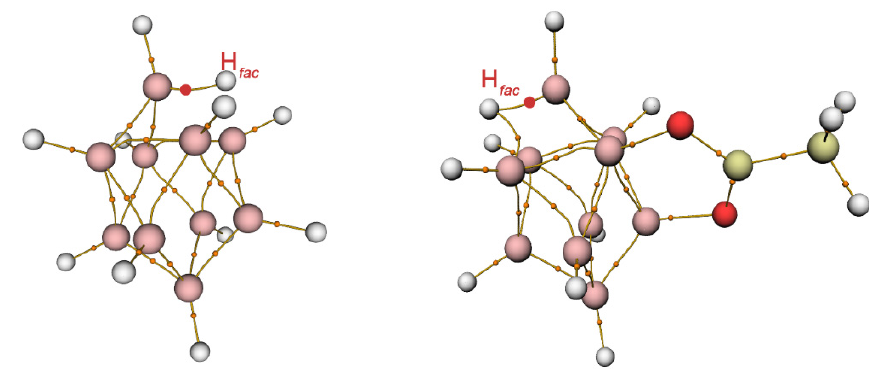
Figure 7. Molecular graph showing the results of the topological analysis of the electron density distribution in the model structures of [B 10 H 11 ] – and [2,6-B 10 H 8 O 2 CCH 3 *H fac ] 0 . The atomic designations are given in Figure 2.